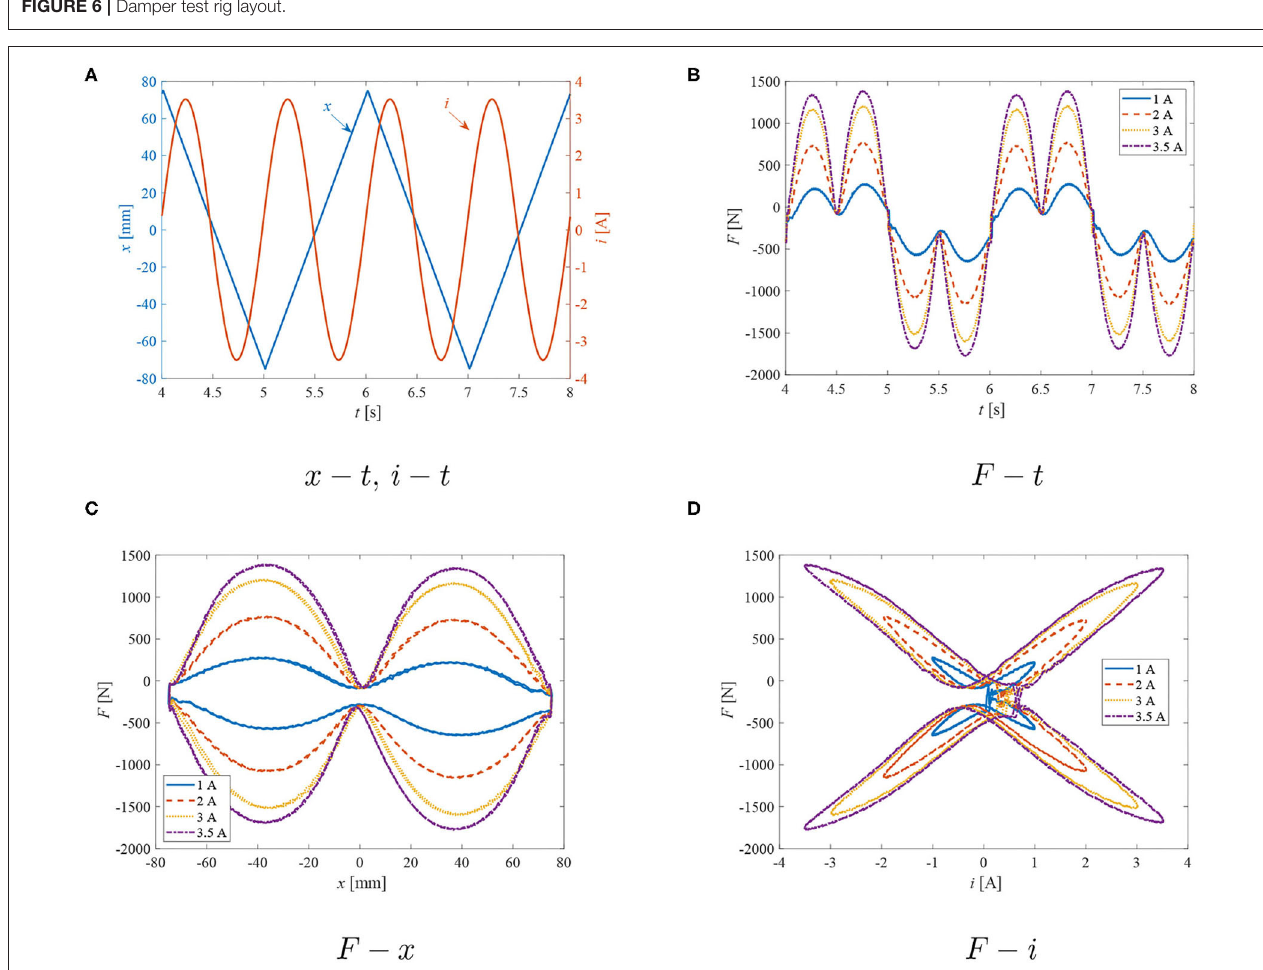
FIGURE 7 | Test results: exemplary excitation inputs, time histories of force, force-displacement, and force-current loops. (A) x − t , i − t . (B) F − t . (C) F − x . (D) F − i .